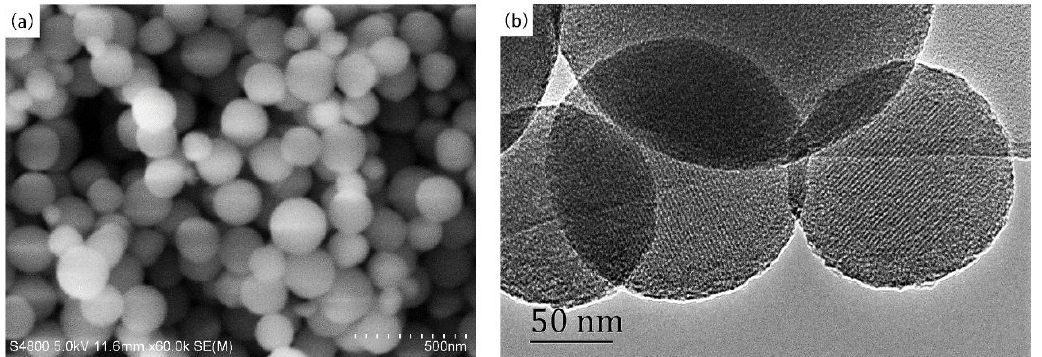
Figure 10. ( a ) Scanning electron microscopy (SEM) image; and ( b ) transmission electron microscopy (TEM) image of the spherical V-Fe-MCM-48 sample.